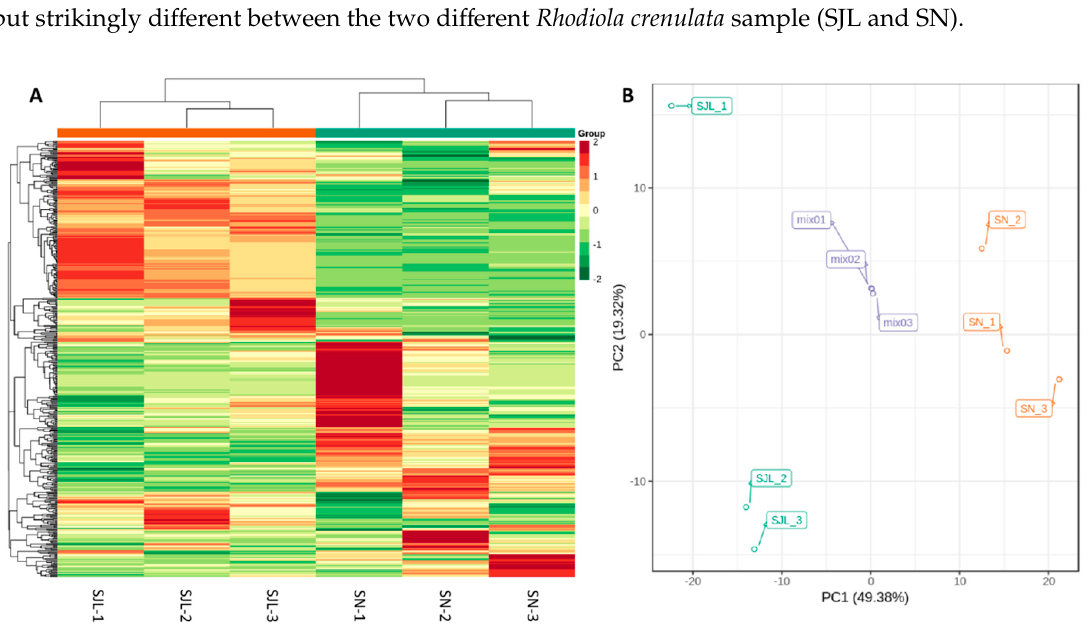
Figure 2. Heat map and principal component analysis (PCA) plots of samples from the two Rhodiola crenulata sample locations with three biological repeats for each sample. ( A ): Heat map; ( B ): Two-dimensional (2D) scatter plot of the PCA for SJL, SN, and the quality control (QC) sample. The QC was a mixture of SJL and SN.